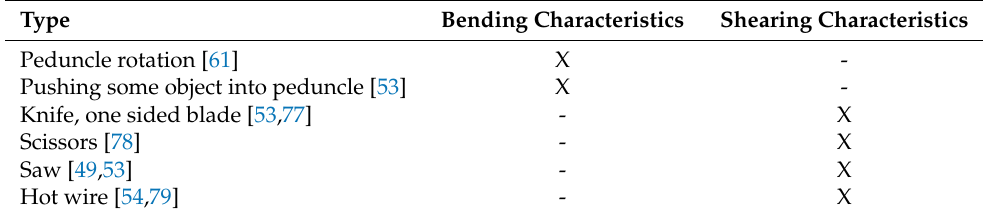
Table 1. Classification of existing grippers.